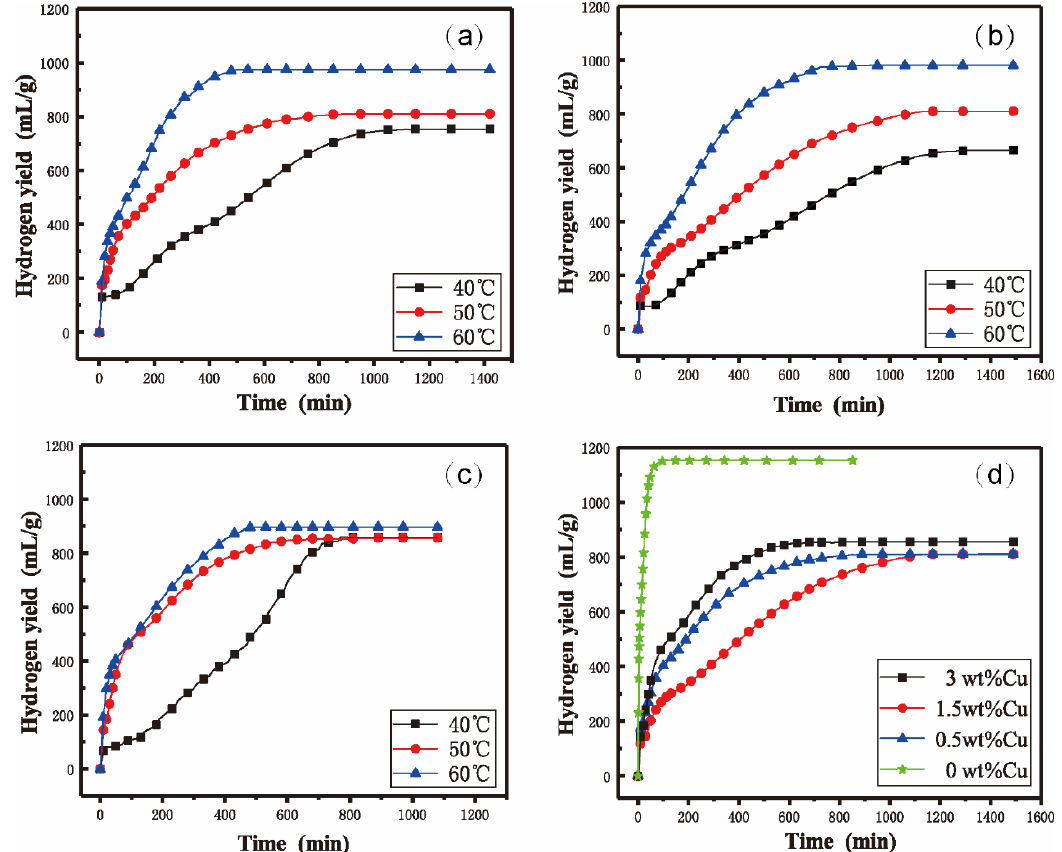
Figure 6. Hydrogen yield of the Al–Bi–Sn–Cu composite powders reacting with distilled water: (a) Al–10Bi–7Sn–0.5Cu, (b) Al–10Bi–7Sn–1.5Cu, (c) Al–10Bi–7Sn–3Cu, (d) Four Al–Bi–Sn–Cu powders at 50 °C.